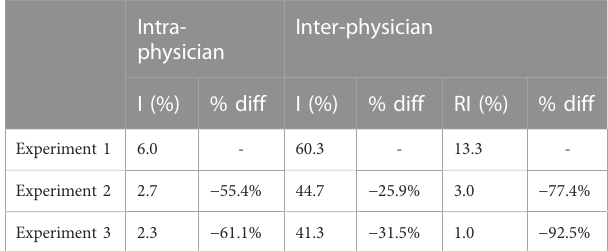
TABLE 5 Intra-physician, Inter-physician and Physicians compared with algorithm percentage of inconsistences (I, %) and relevant inconsistences (RI, %) in each experiment. For experiments 2 and 3 also expressed relative reduction of inconsistences with respect to experiment 1 expressed in column “ % diff ” . For intra-physician, the percentage of inconsistences is estimated over the 50 sets of two radiographs of the same patient (150 sets in each experiment), while for the inter-physician is over the 100 radiographs (300 in each